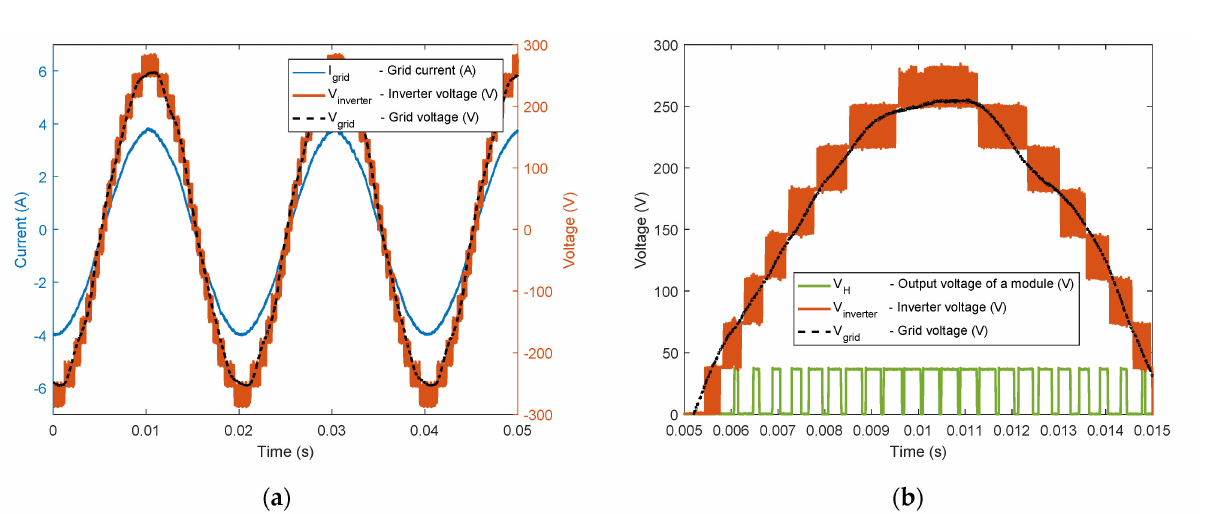
= 3 A, N = 8, V = 180 V: Current grid gridrms rms i